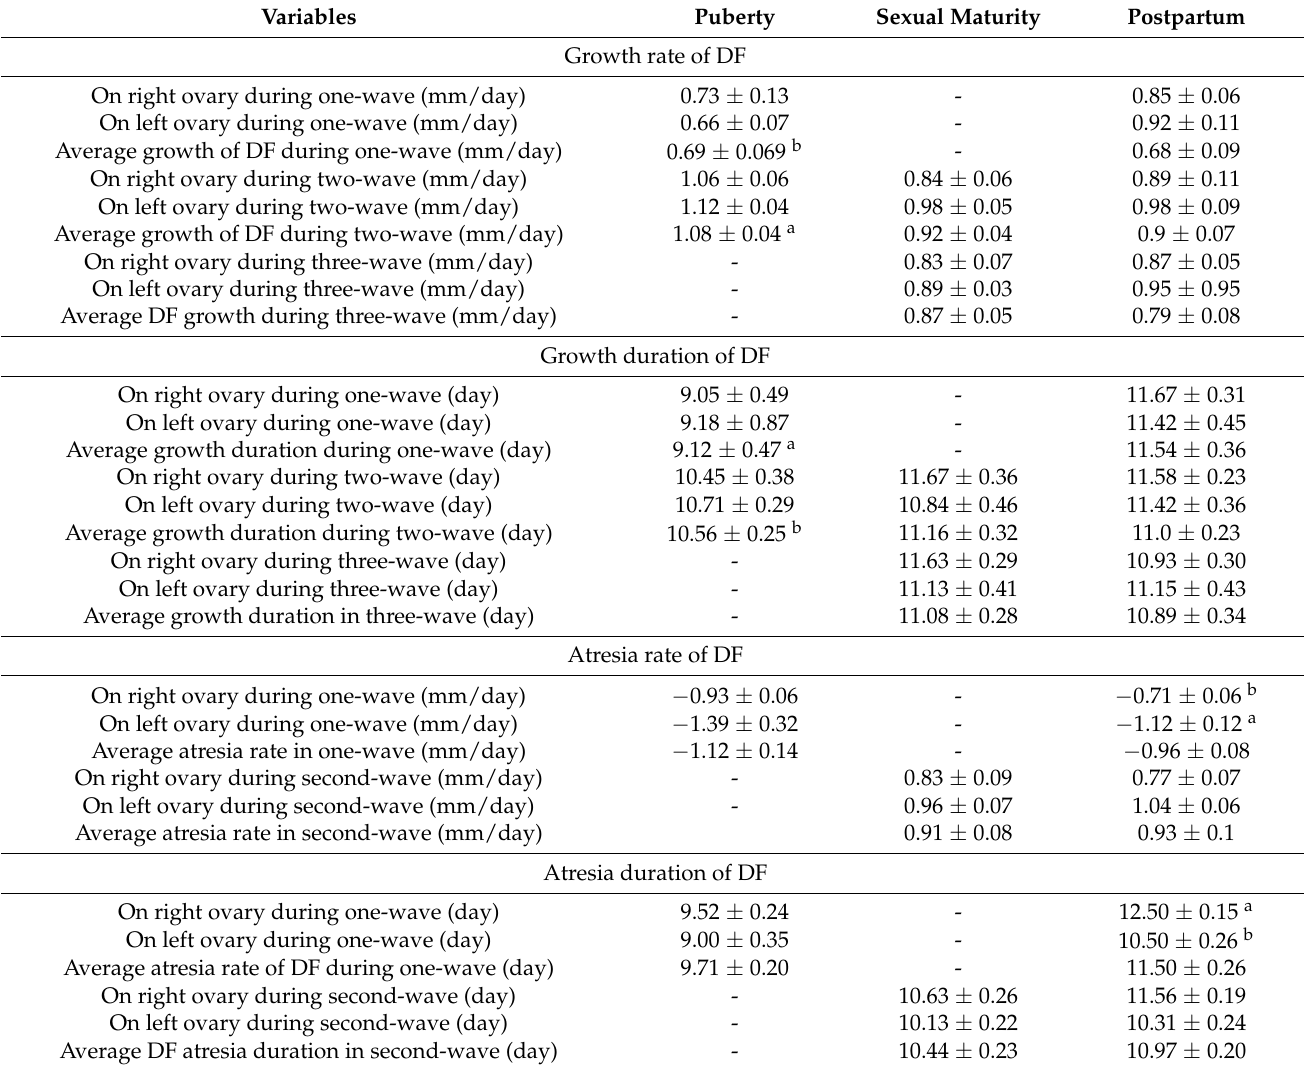
Table 4. The growth and atresia of dominant follicle (DF) inter-estrous cycle of crossbred buffaloes during pubertal ( n = 28), maturity ( n = 22) and postpartum ( n = 18) stages. Variables Puberty Sexual Maturity